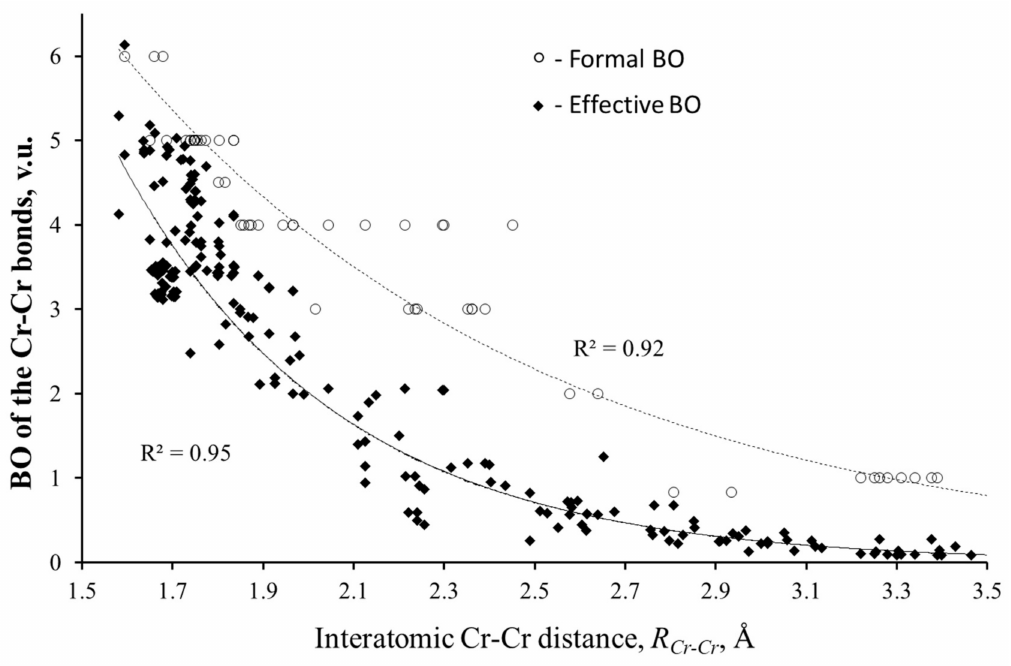
Figure 1. Formal and effective bond orders (BOs) of the Cr–Cr bonds vs. interatomic Cr–Cr